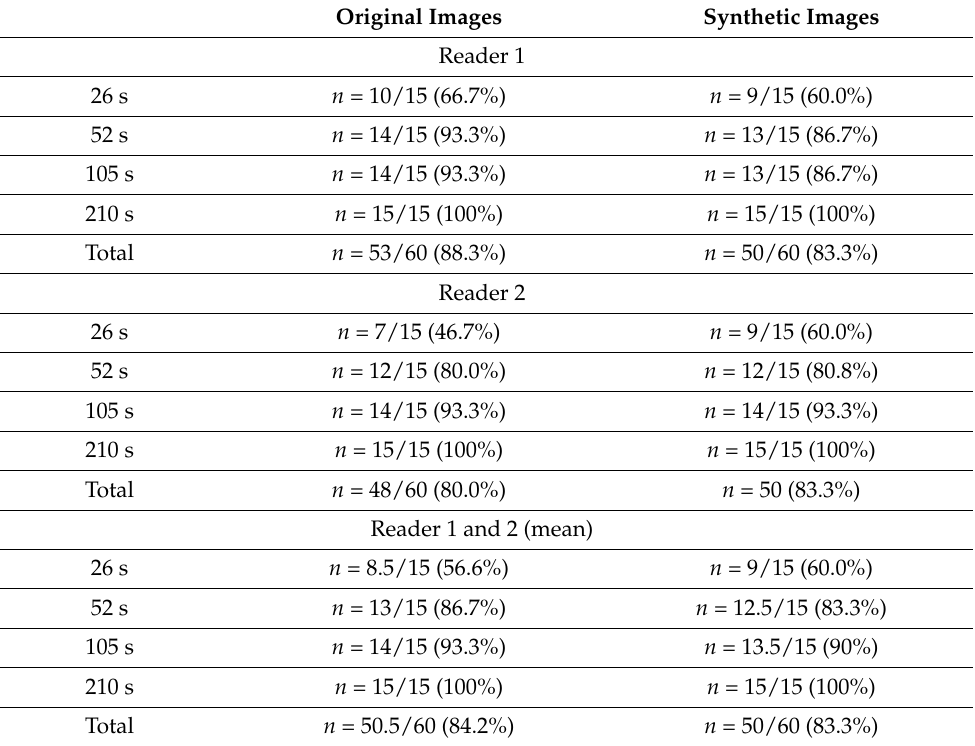
Table 3. Comparison of the detection rates of abnormal accumulation between the original and synthetic images.